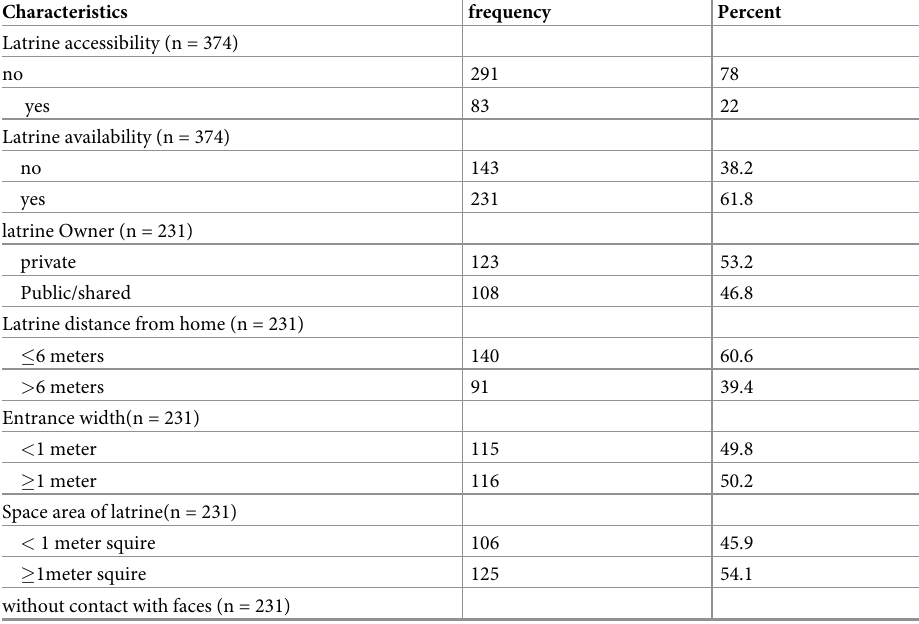
Table 2. Latrine accessibility among PwPDs in Kombolcha town, April